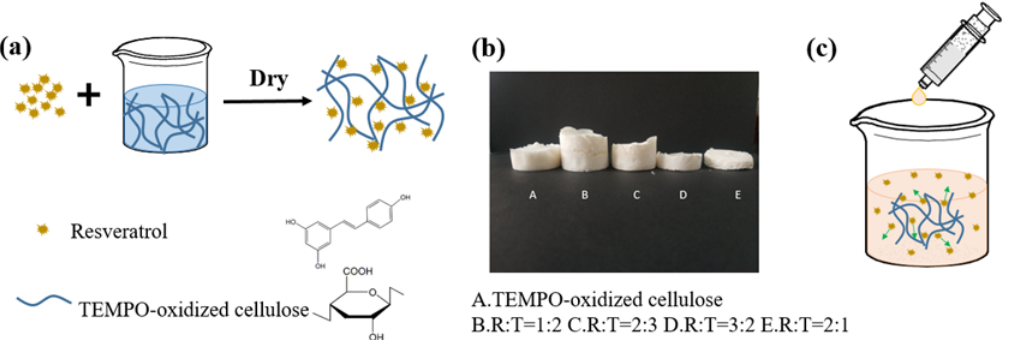
Figure 1. ( a ) Synthesis sketch of Resveratrol-loaded TEMPO-oxidized cellulose aerogel (RLTA), ( b ) digital photographs of RLTA with different Resveratrol (Res) and TEMPO-oxidized cellulose (TC) mass ratios, ( c ) drug release sketch of Res from simulated gastric juice or phosphate buffer.